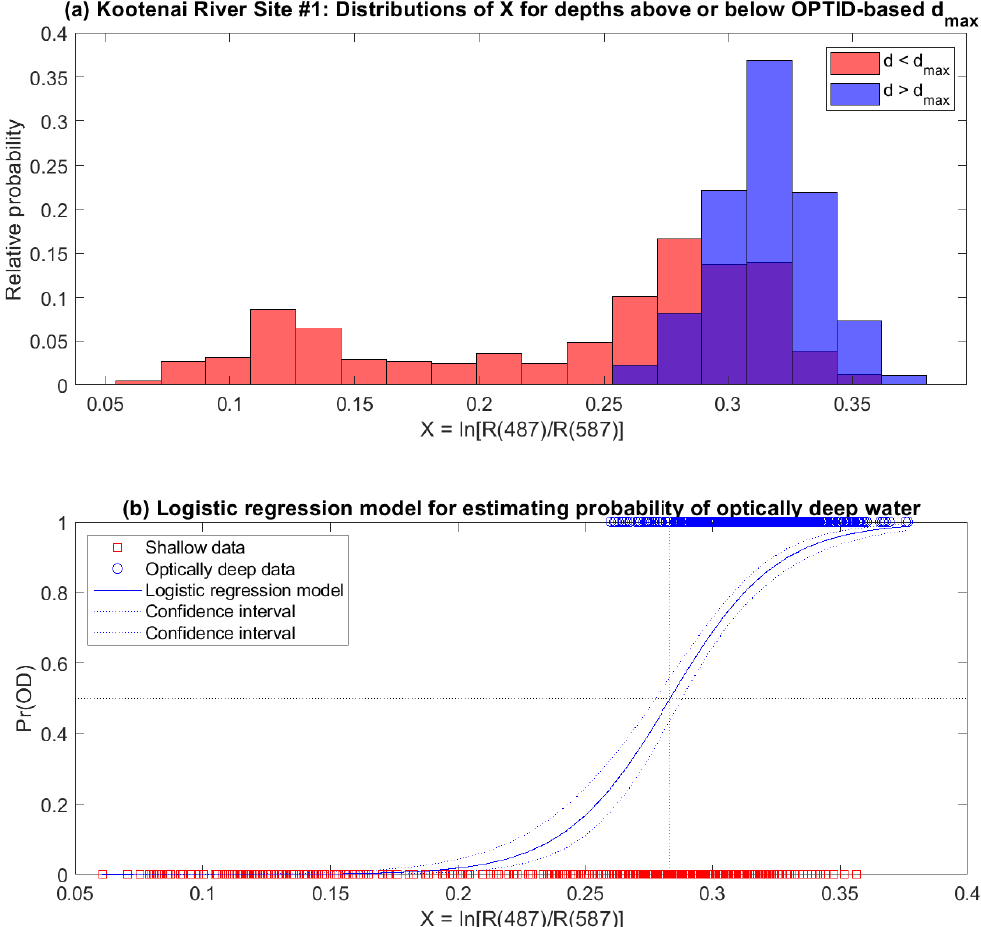
Figure 7. ( a ) Histograms of X for pixels with measured depths shallower than or deeper than d max inferred via OPTID; ( b ) logistic regression model for estimating Pr ( OD ) , the probability of optically deep water. The horizontal and vertical dashed lines represent the probability cutoff for distinguishing shallow and deep areas of the channel based on a threshold value of X